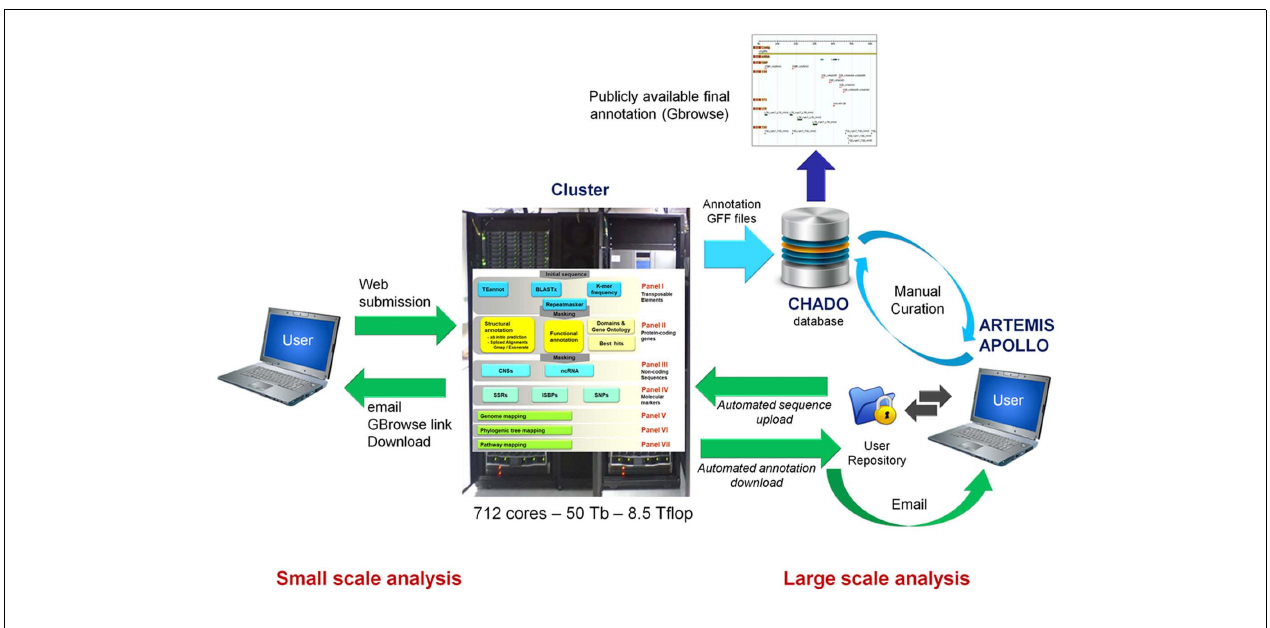
direct manual curation in a CHADO database is described on the right hand side.The curation can be performed either with ARTEMIS, GenomeView or APOLLO graphical editors. Curated annotation can then be displayed with a GBrowse graphical viewer through internet. The future architecture of the pipeline with seven panels is represented on the